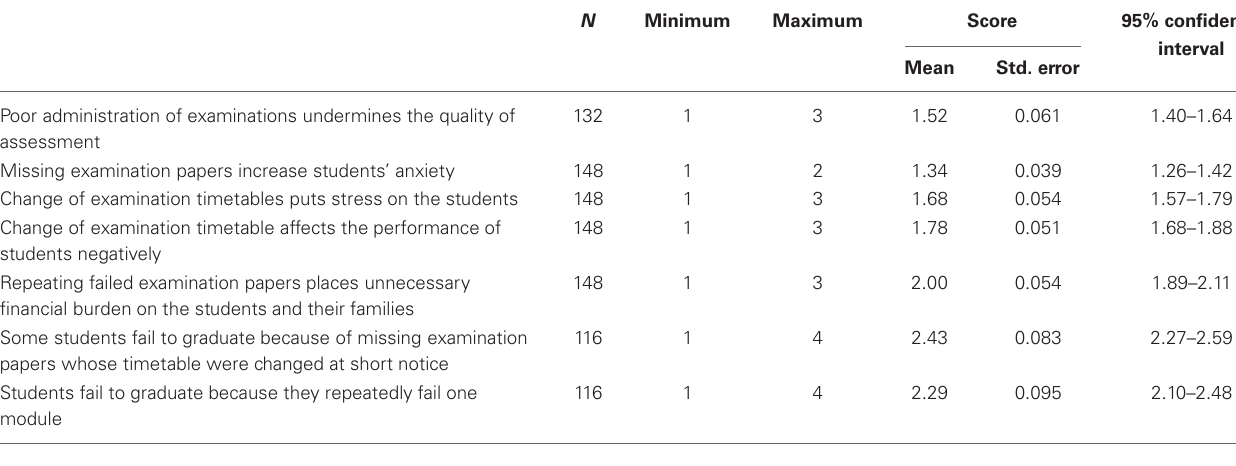
Table 10 | Ethical conduct of examinations.